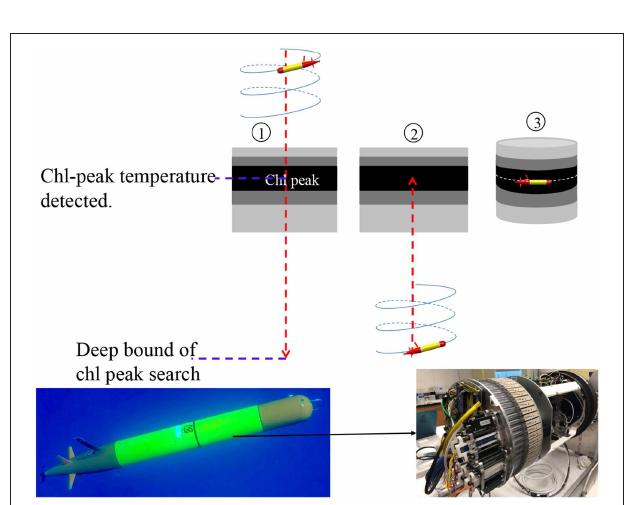
FIGURE 8 | Illustration of the AUV algorithm for autonomously finding the DCM temperature and tracking that isotherm (Upper) . The gray scale level represents the chlorophyll signal level. The darkest layer represents the DCM. The bottom photos [courtesy of Elisha Wood-Charlson (Left) and James Birch (Right) ] show the LRAUV Aku equipped with a 3G-ESP in the fore-mid